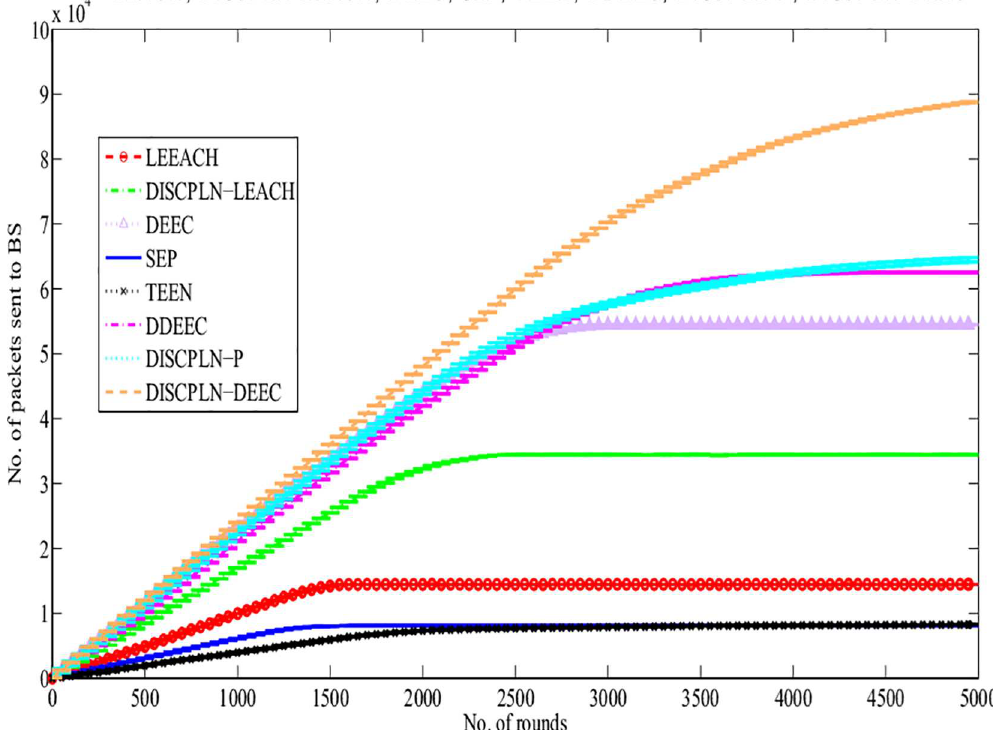
Fig 7. Performance comparisonbasedon throughputfor